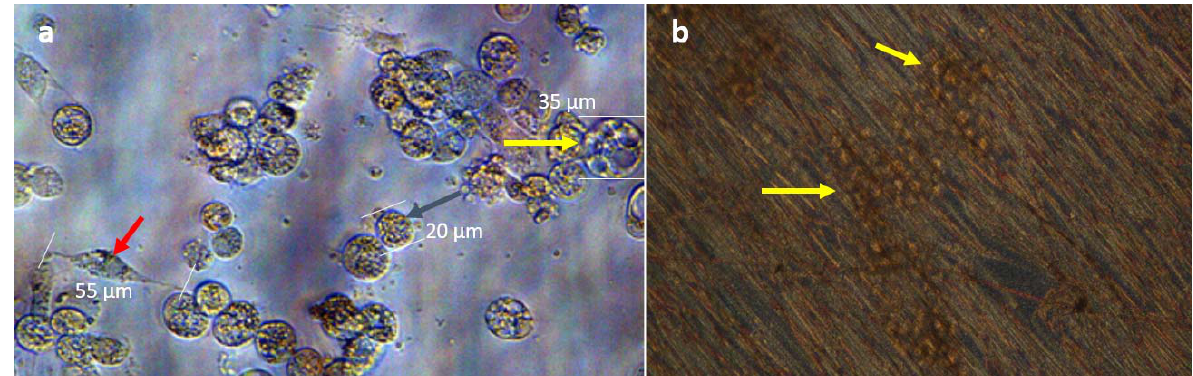
Figure 5. Light microscopy of BmVIII-SCC cells in passage 32 that were cultured in disks with polyethylene terephthalate (PET) aligned nanofibers. ( a ) Luminal orientation day 8 post ‐ infusion of fibroblast ‐ like cells (red arrow), large vacuolated cells (yellow arrow), and small granular cells (dark olive arrow) at 400X. ( b ) Interior view of PET disk on day 35 post ‐ infusion showing cell aggregates (yellow arrows) 200X.